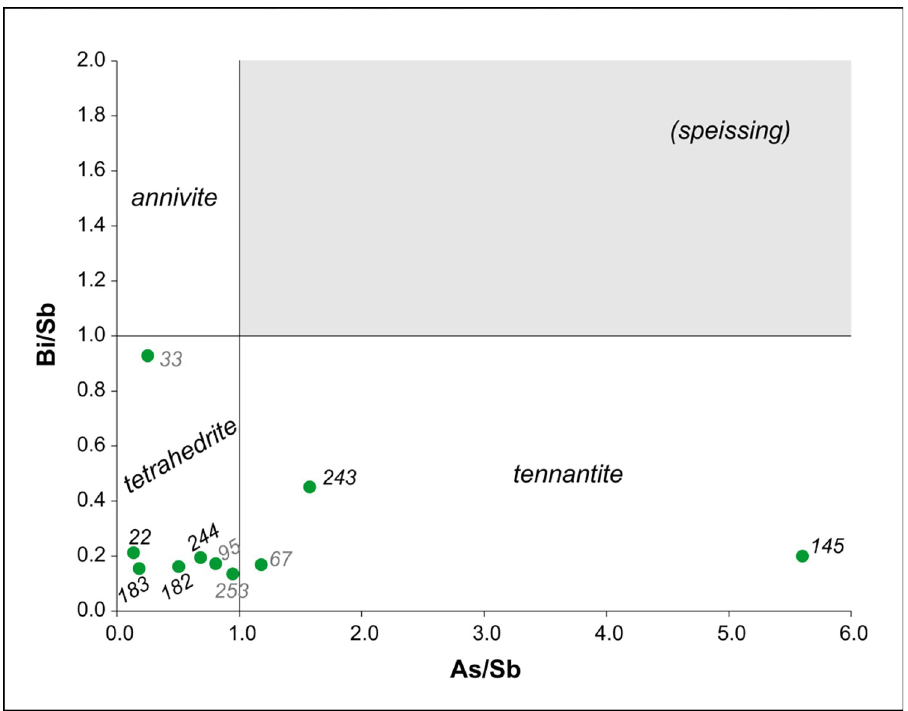
Fig 20. The bismuth/antimony (Bi/Sb) ratio versus the arsenic/antimony (As/Sb) ratio.